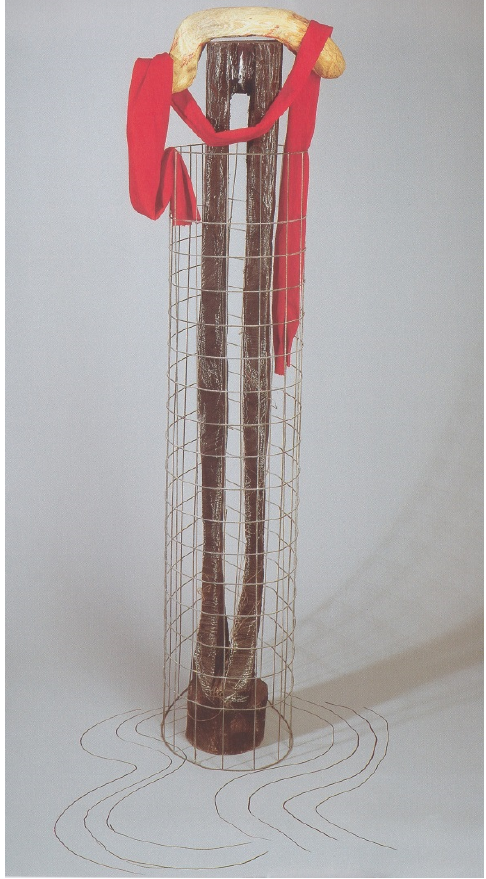
Figure 9. Leon Podsiadły, Striptease , 2012, metal, wood, fabric. Photograph by Stanisław Sielicki. After: (Wąs 2012a, p. 102). Photo used with the permission of the artist’s family.